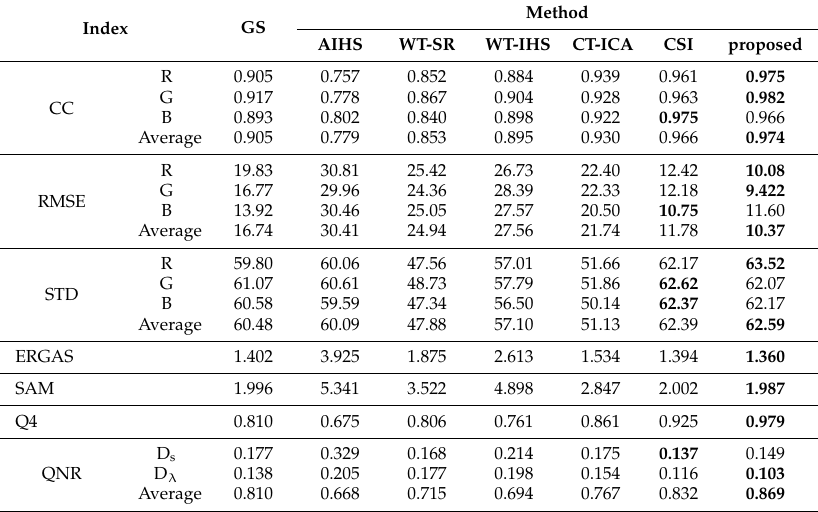
Table 4. Evaluation indices of fusion results for Triplesat